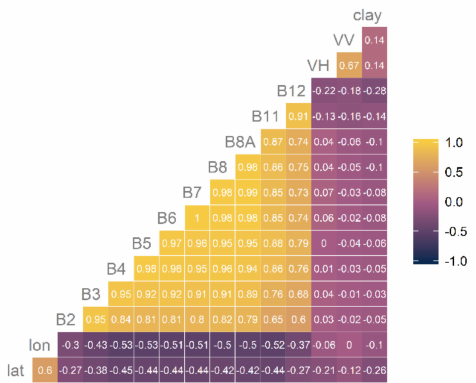
Figure 3. Correlogram based on Pearson’s correlation considering all the available Sentinel-1 and Sentinel-2 values, as well as the coordinates (lat and lon) and the soil clay content from the selected topsoil